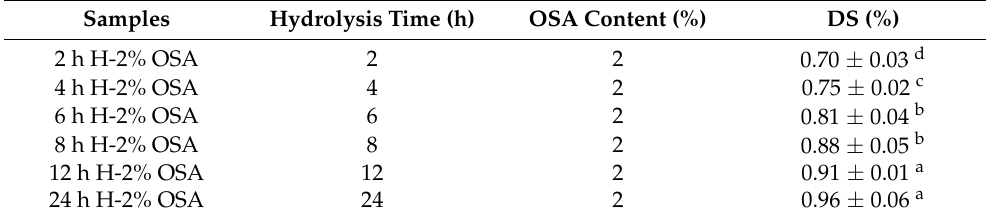
Table 1. The effects of different time intervals of acid hydrolysis on the degree of substitution. Samples